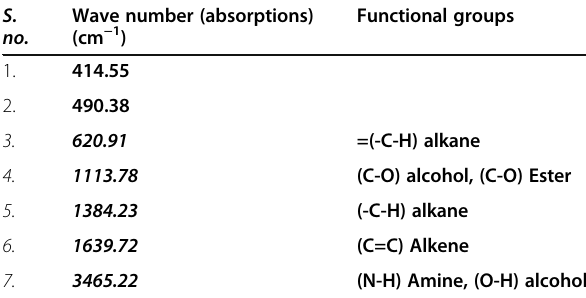
Table 3 FT — IR analysis (Fourier-transform infrared spectroscopy)